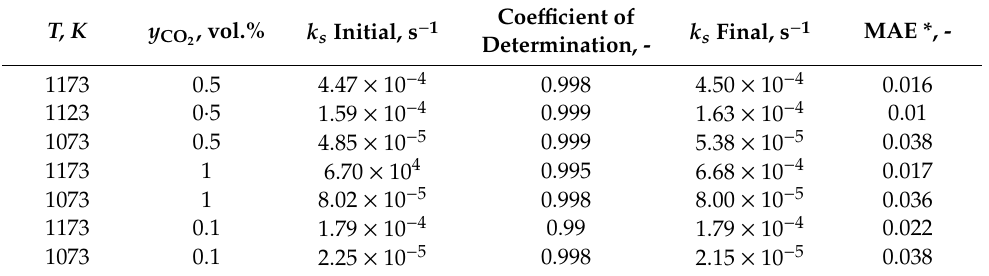
Table 5. Fit statistics and